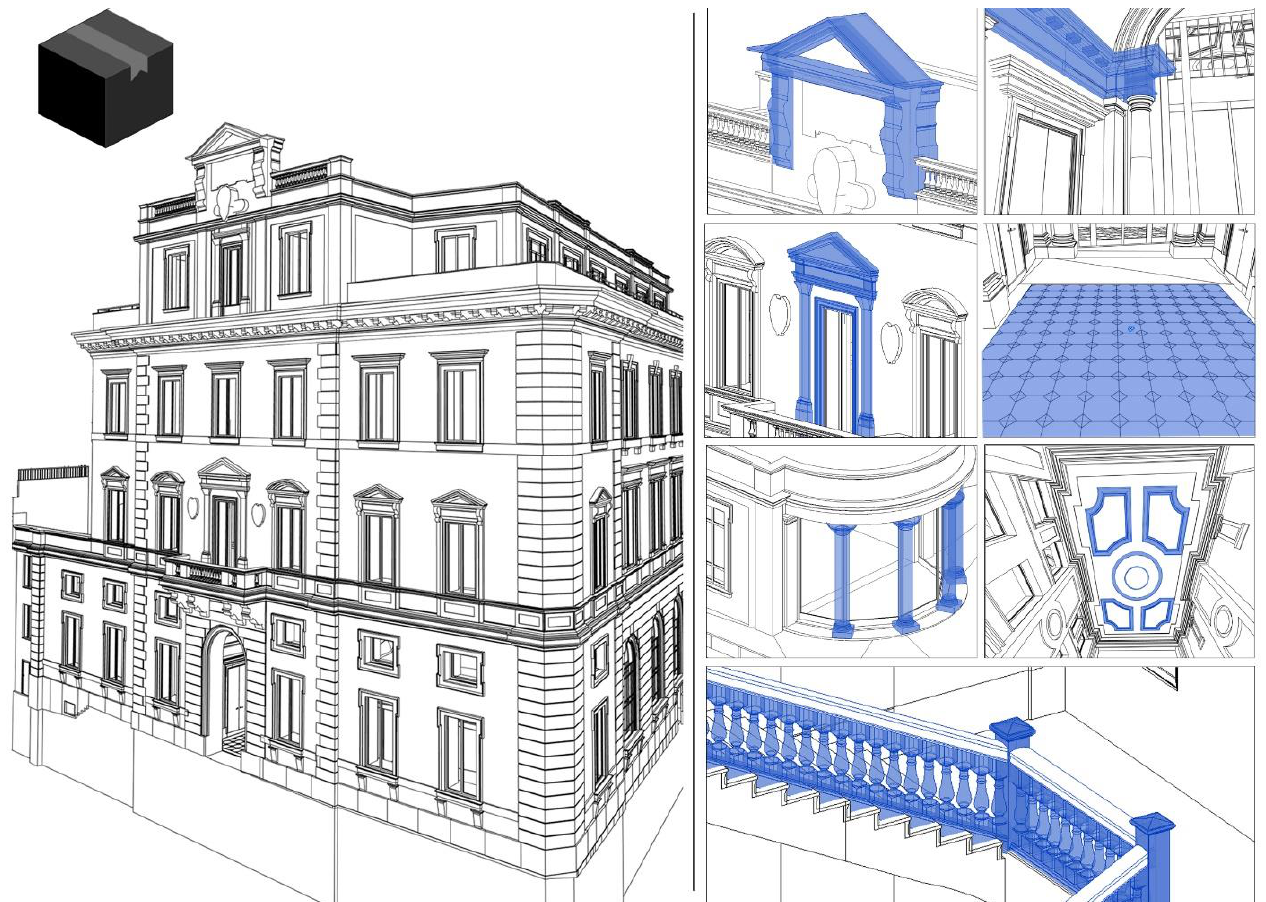
Figure 5. The building in Piazza Borghese, the elements of the “black box” model.